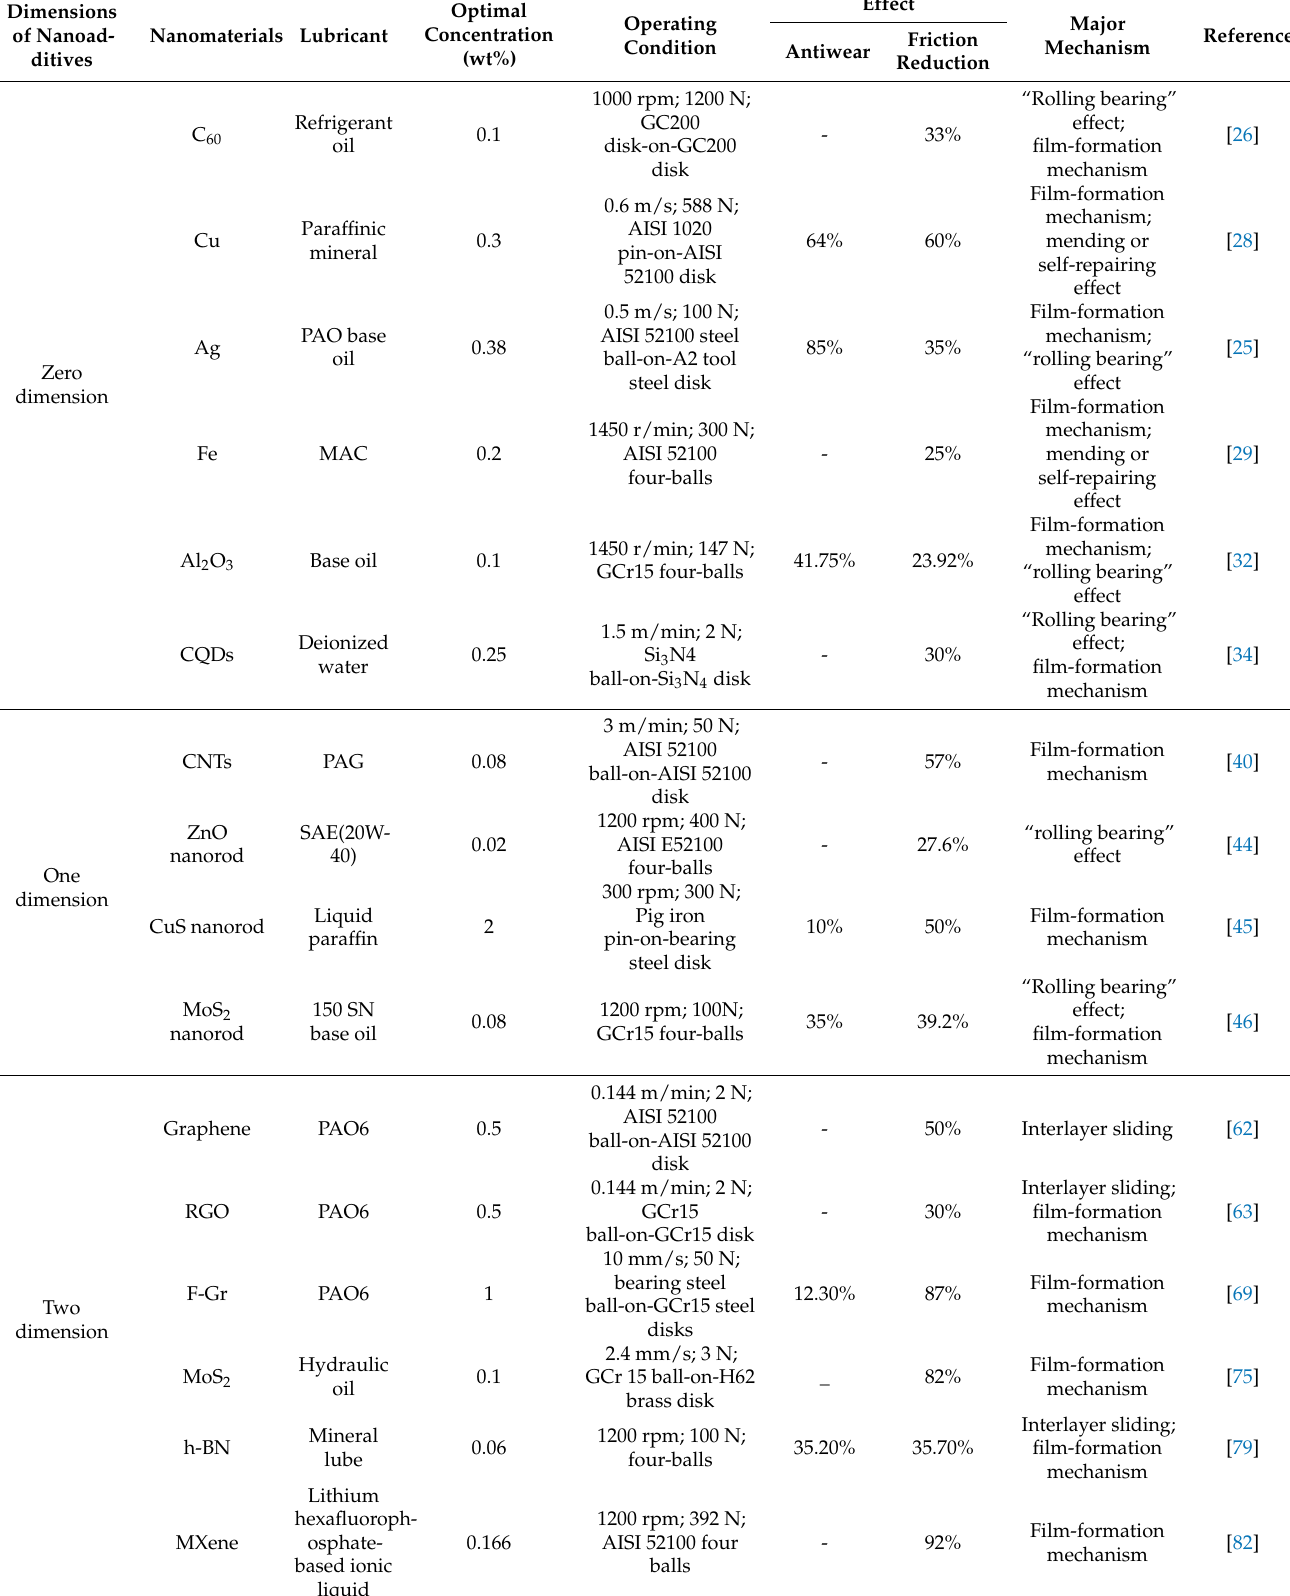
Table 2. Tribological performance of nanomaterials with different dimensions as lubricant